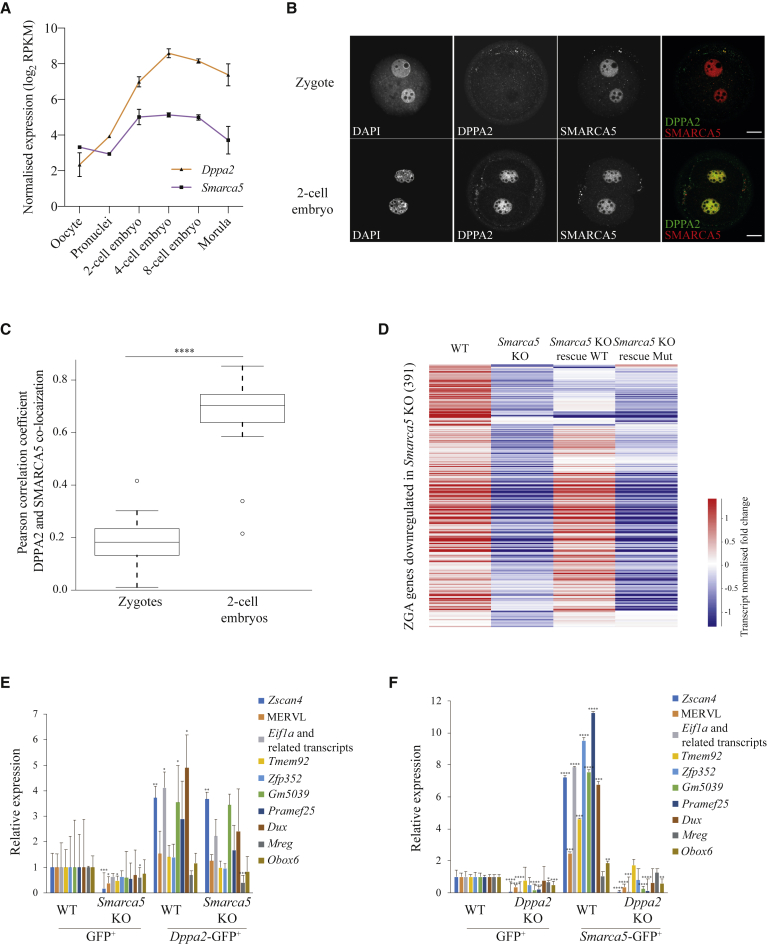
Smarca5 Requires Dppa2 to Induce ZGA-like Transcription(A) Normalized expression levels (log2 reads per kilobase per million; RPKM) of Dppa2 (orange, triangles) and Smarca5 (purple, squares) in oocytes and preimplantation development (data analyzed from Xue et al., 2013). Data are shown as mean plus standard deviation of biological replicates.(B) Representative single optical slices of zygotes (top row) and two-cell stage embryos (bottom row) immunostained for DPPA2 and SMARCA5, showing single channels and composites. Scale bars represent 20 μm.(C) Box-plots showing Pearson correlation coefficients calculated for co-localization of DPPA2 and SMARCA5 in the pronuclei of 10 zygotes and in the nuclei of 10 two-cell stage embryos. Co-localization values in the two pronuclei in zygotes and nuclei of each blastomere in two-cell embryos were measured separately. DPPA2 and SMARCA5 co-localize in two-cell embryos but not in zygotes (∗∗∗∗p value < 0.0001, Mann-Whitney two-tailed test).(D) Heatmap showing normalized expression, scaled per gene, of downregulated ZGA genes in Smarca5 KO mouse ESCs compared to WT (EdgeR, FDR < 0.05), in WT ESCs, Smarca5 KO ESCs, and Smarca5 KO ESCs expressing a Smarca5 WT protein or a Smarca5 catalytically dead mutant protein (Mut) (data analyzed from Barisic et al., 2019).(E and F) Analysis of relative expression levels of ZGA-like transcripts by quantitative reverse transcription PCR in (E) WT and Smarca5 KO mouse ESCs after 48-h transient transfection of eGFP or Dppa2-eGFP and (F) WT and Dppa2 KO mouse ESCs after 48-h transient transfection of eGFP or Smarca5-eGFP. eGFP+ cells were FACS-sorted before gene expression analysis. Relative expression levels are normalized to WT cells transfected with eGFP and sorted for eGFP+. Data are shown as mean plus standard deviation of three biological replicates. Statistically significant differences to WT GFP+ control are reported (∗∗p value < 0.01, ∗∗∗p value < 0.001, ∗∗∗∗p value < 0.0001; absence of stars (non-significant): p value > 0.05; homoscedastic two-tailed t test).